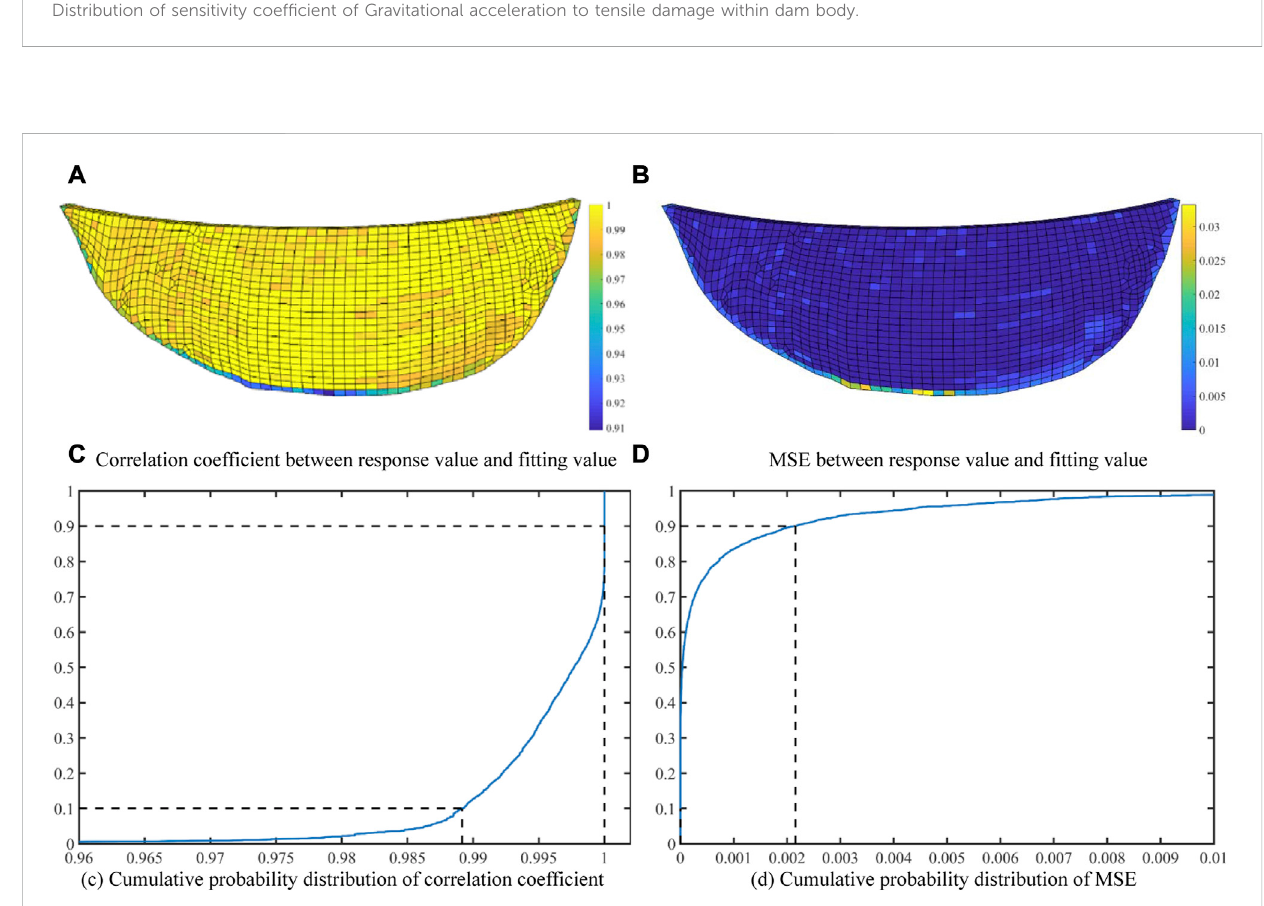
FIGURE 12 (A,B) correlation coef fi cient and MSE distribution of tensile damage surrogate model within the dam body; (C,D) cumulative probability distribution of correlation coef fi cient and MSE of tensile damage surrogate